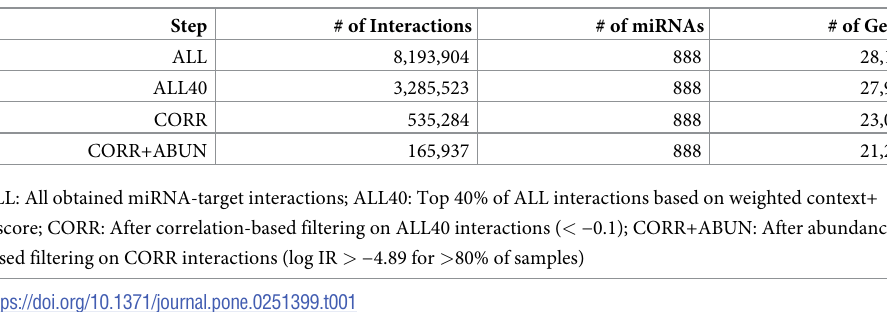
strong Pearson correlation based on expression, and iii) strong collective regulation between the group and the neighbor.